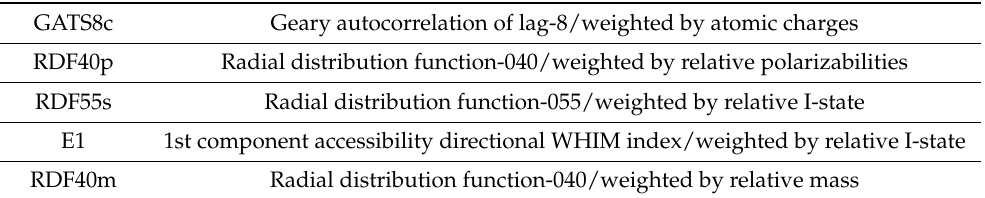
Table 1. List of descriptors obtained from Ref. [115] used along with the electrophilicity index to develop QSTR models describing the HAT activity of pyridyl benzamide